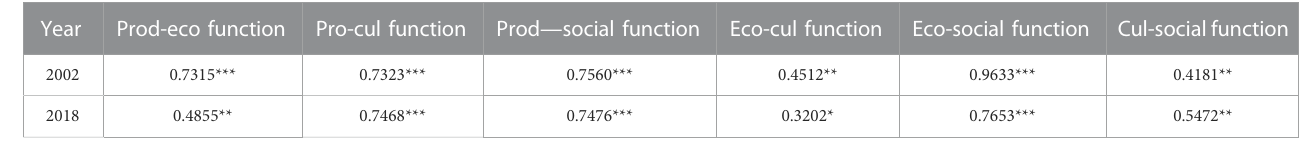
TABLE 1 Multi-functional correlation of cultivated land in 2002 and 2018.